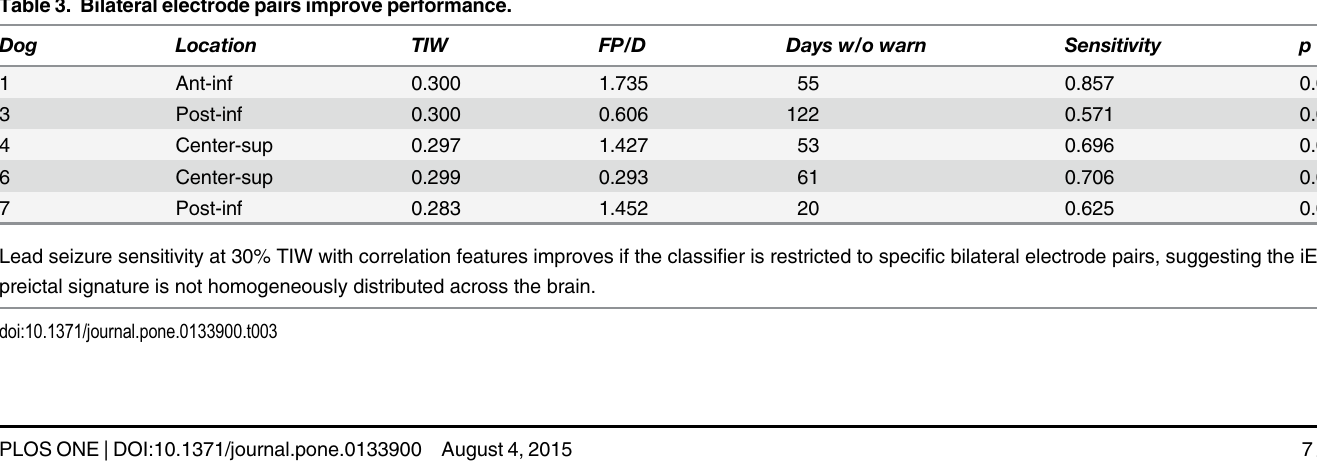
PLOS ONE | DOI:10.1371/journal.pone.0133900 August 4,